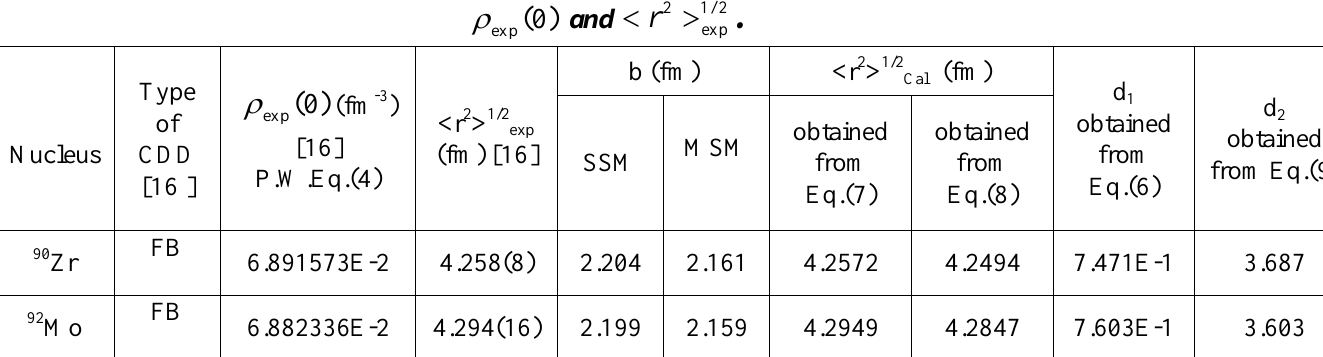
Table 3: The Values of various parameters employed in the present calculations together with